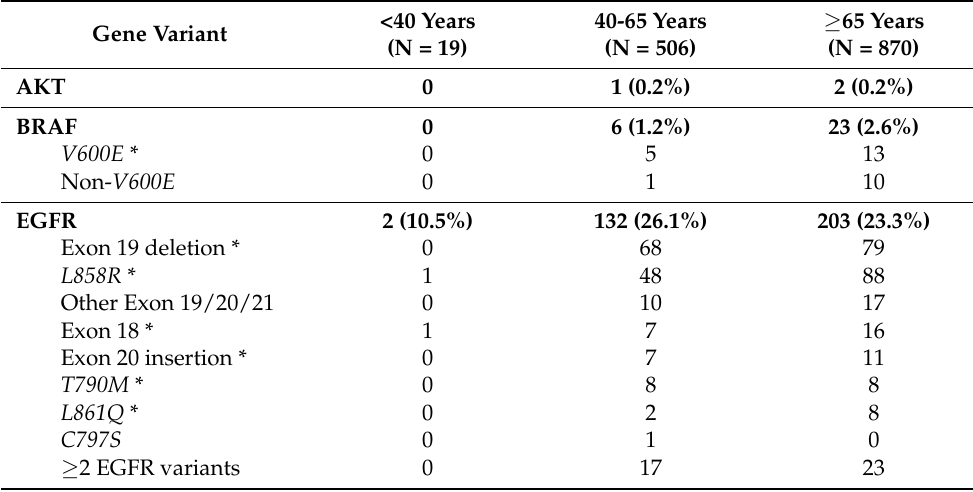
Table 4. Molecular results by patient